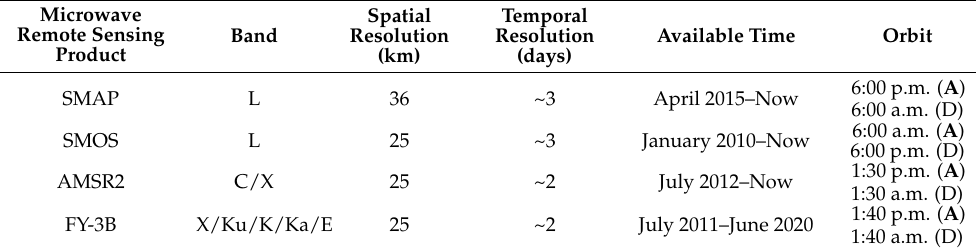
Table 2. The characteristics of the microwave remote sensing